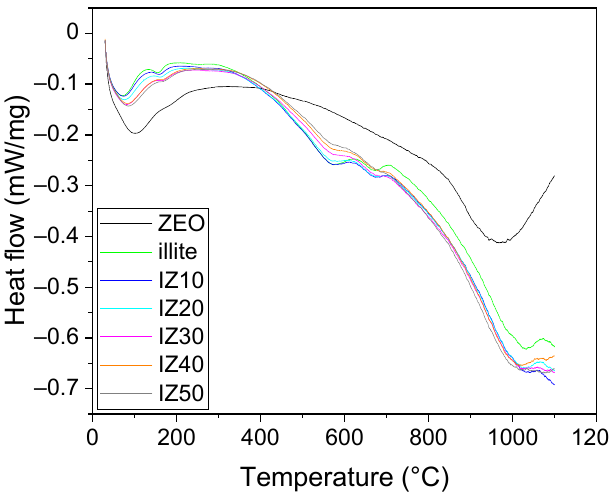
Figure 2. DSC analysis of the mixtures and initial materials.